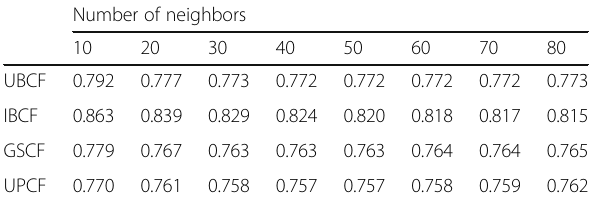
Table 1 Comparison table for MAE value